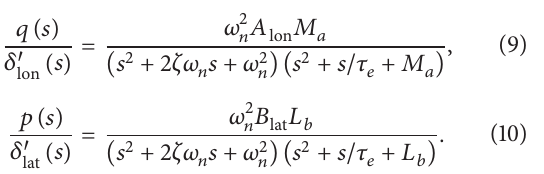
Figure 1: The I/O data of lateral channel.